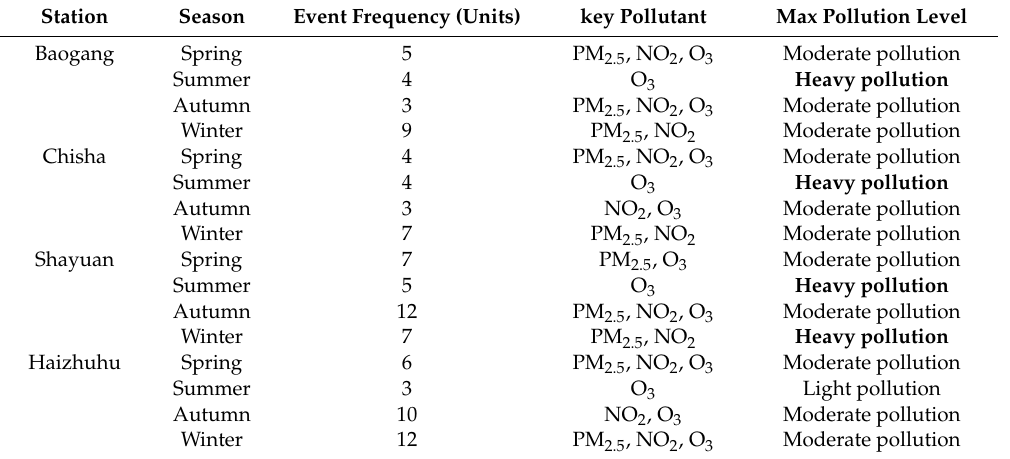
Table 2. Pollution episodes observed at Haizhu monitoring stations in